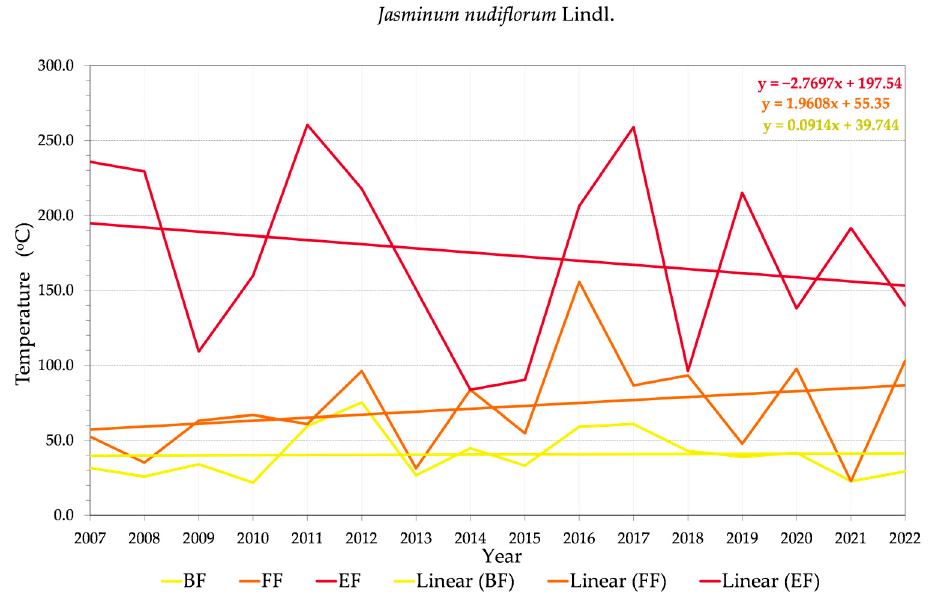
Figure 2. Linear trends of observed phenological phases based on temperature sums in the period 2007–2022 for the beginning of the flowering (BF), full flowering (FF), and the end of flowering (EF) for 13 woody taxa.